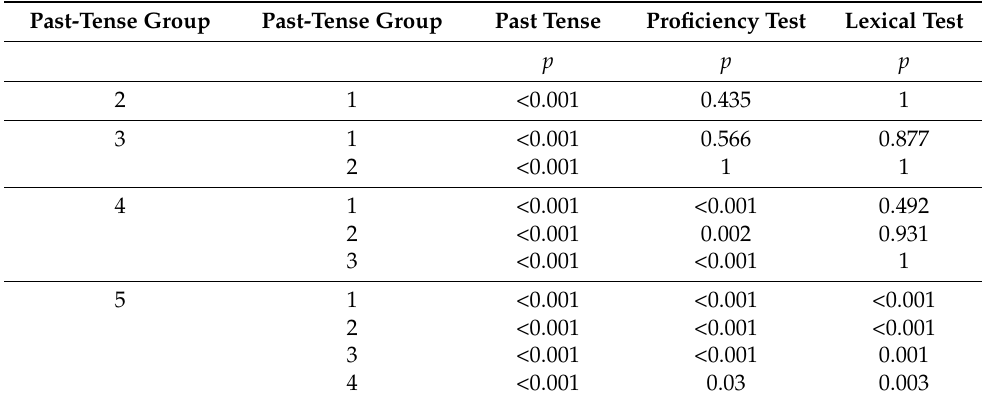
Table A1. Probabilities for between-group mean